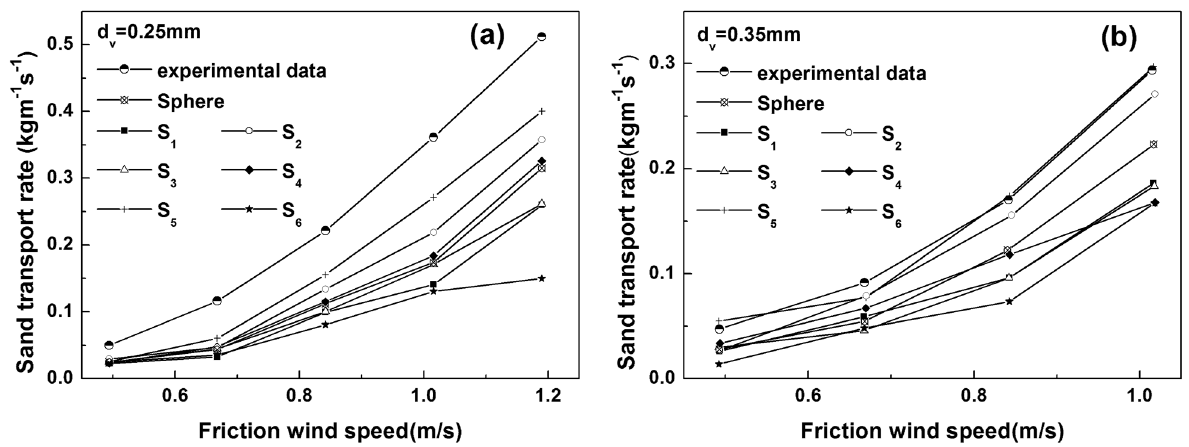
Figure 6. The sand transport rate per width for sand particles of different shape. (a). Comparison of calculated sand transport rates per width for different shapes sand particles with equivalent diameters of d v ~ 0 : 25 mm with experimental data. (b). Comparison of calculated sand transport rates per width for sand particles of different shape with equivalent diameters of d v ~ 0 : 35 mm with experimental data. The black solid line indicates spherical sand grains, S 1 and S 2 are two different ellipsoid-shaped sand particles, S 3 represents cube-shaped sand particles, S 4 and S 5 are two types of cylinder-shaped sand particles, and S 6 represents frustum-shaped sand particles.